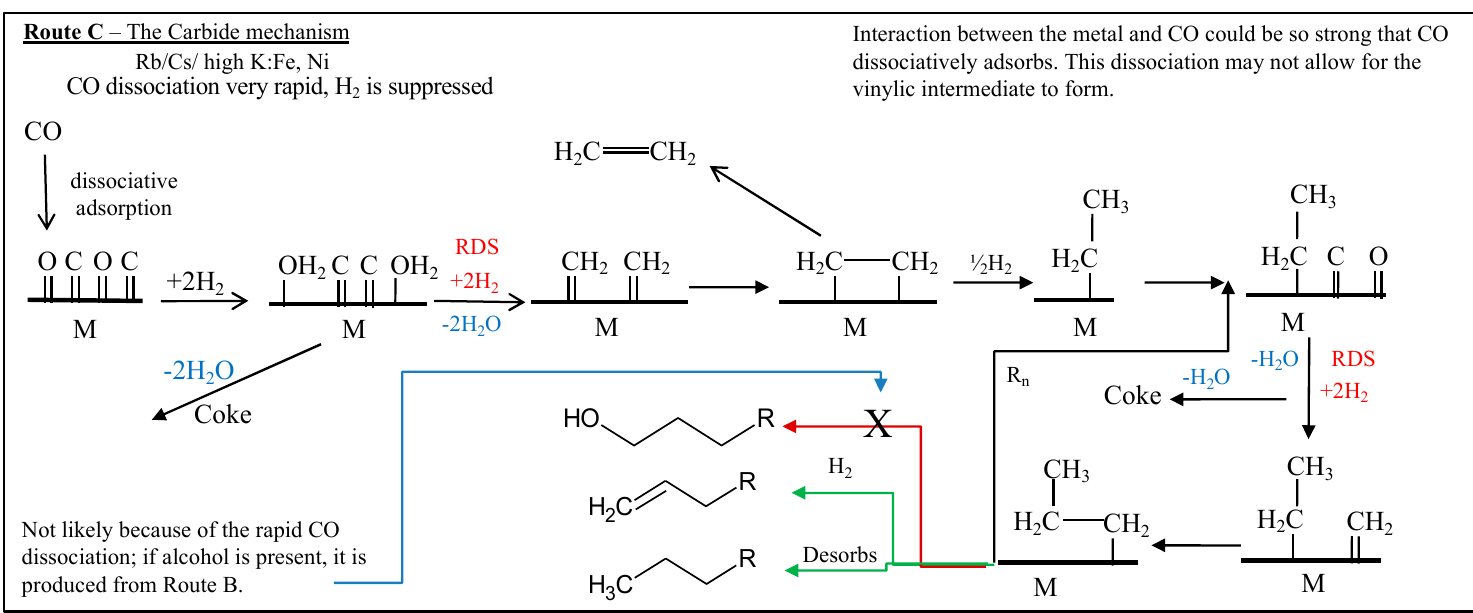
Figure 44. Proposed route C for the formation of several products that are observed in FTS, based on the carbide mechanism. Here, methane and coke are formed, where the back-donation of electron density is too strong; thus, the strong back-donation of electron density precludes the formation of the vinylic chain growth intermediate. With metals like nickel, where hydrogen is not as suppressed, methane would be the main product. However, as hydrogen becomes suppressed due to the high dissociation rate of CO (because of the increased interaction), the surface becomes covered with carbonaceous deposits.